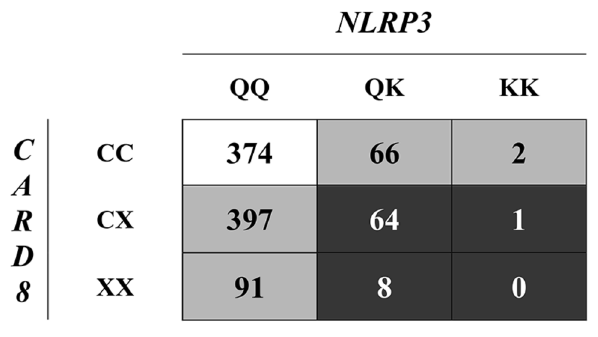
Figure 1. Sub-set selection of Cases and Controls. Genetic analysis was performed in a cohort of 1003 healthy blood/plasma donors. Seventy-three individuals (i.e. 7.3% of the cohort) carried the combined polymorphisms of NLRP3 (Q705K) and CARD8 (C10X) (black boxes), and were selected and referred to as combined cases. As controls, 147 age and gender matched wild-types (white box) were selected. In addition, samples from individual being homozygote (n=47) or heterozygote (n=50) for C10X, or homozygote (n=2) or heterozygote (n=50) for Q705K were referred to as cases (grey boxes). As controls, 100 age and gender matched wild-types (white box) were